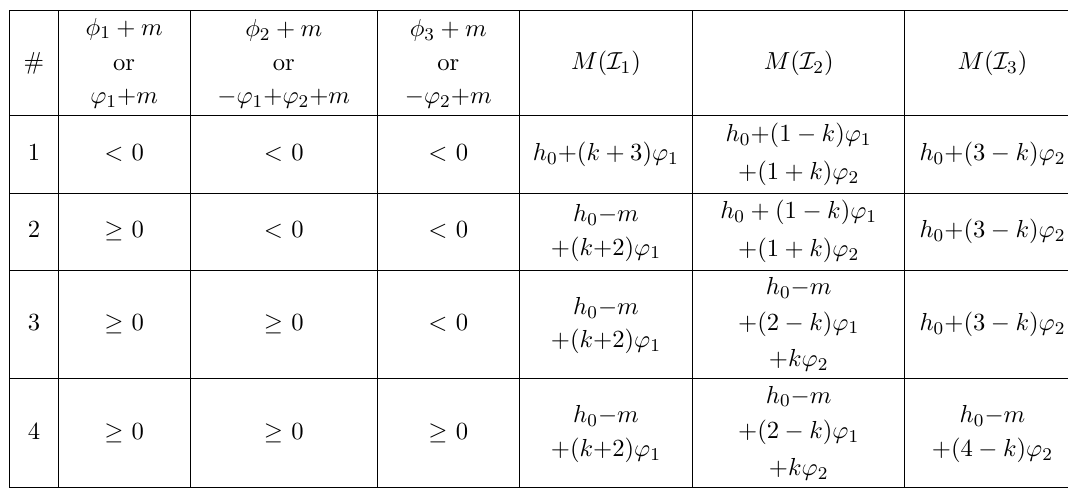
Table 5 . Chamber de(cid:12)nitions of the U(3) k corresponding instanton masses. The variables ( (cid:30) 1 ; (cid:30) 2 ; (cid:30) 3 ) denote U(3) vevs, while the variables ( ’ 1 ; ’ 2 ) denote SU(3)